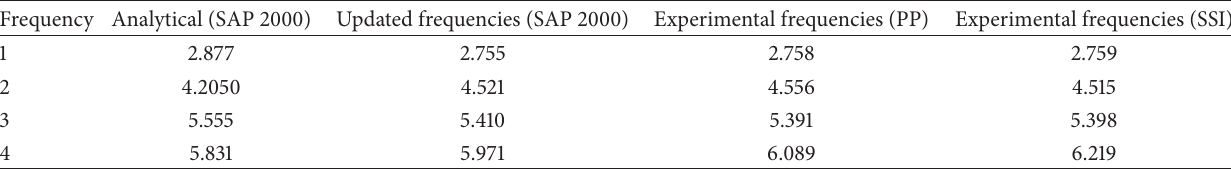
Figure 9: The frequency response function (PP method) and stabilization diagram of the measurement (SSI method). Table 4: Updated and experimental modal